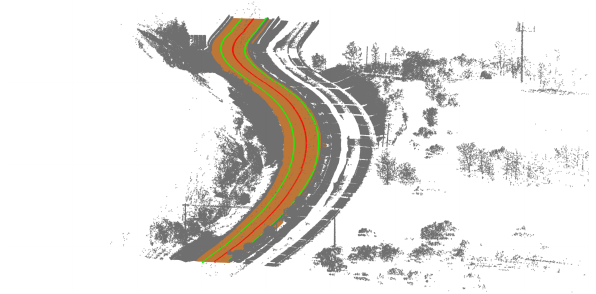
Figure 2. The road alignment of this highway section (red colour) is defined as de central axis of the road, which is delimited by its edges (green colour).